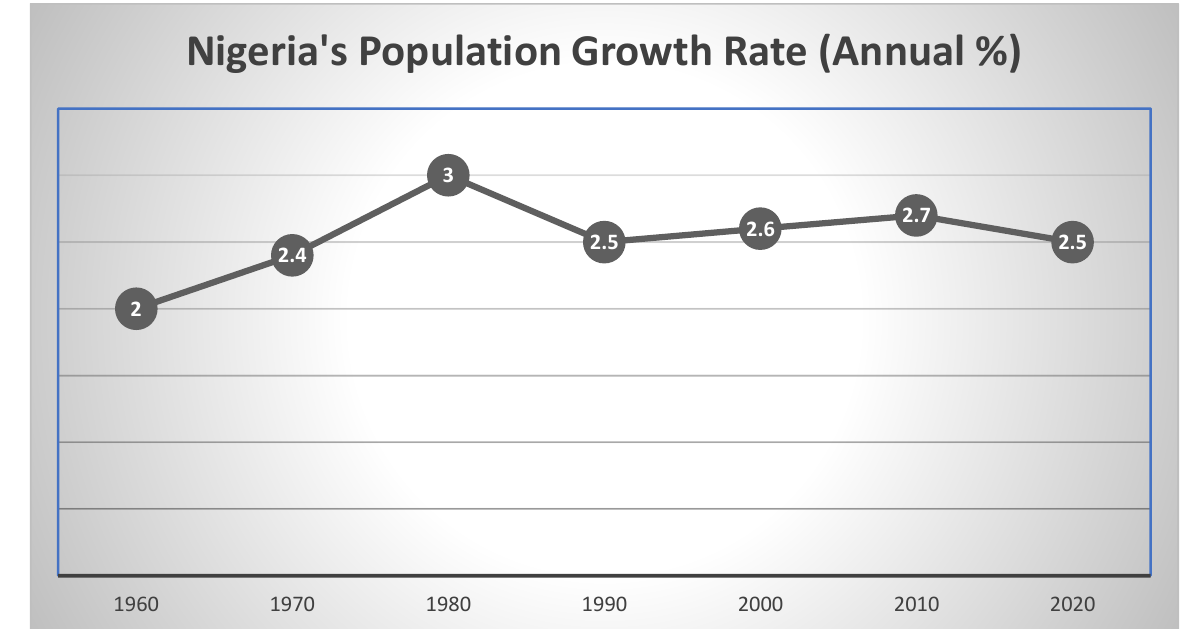
Figure 7. Nigeria’s Population Growth Rate (up to 2020). Source: Author.